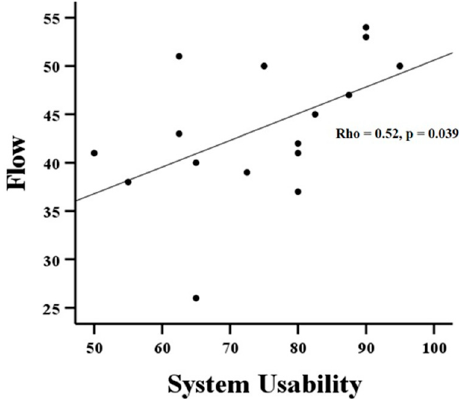
Figure 5. Correlation between flow and usability ratings. No significant correlations between SUS